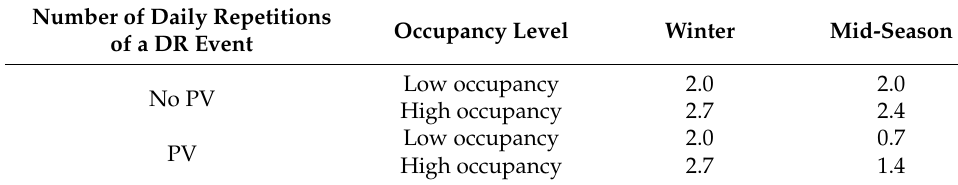
Table 4. Daily repetitions of a DR